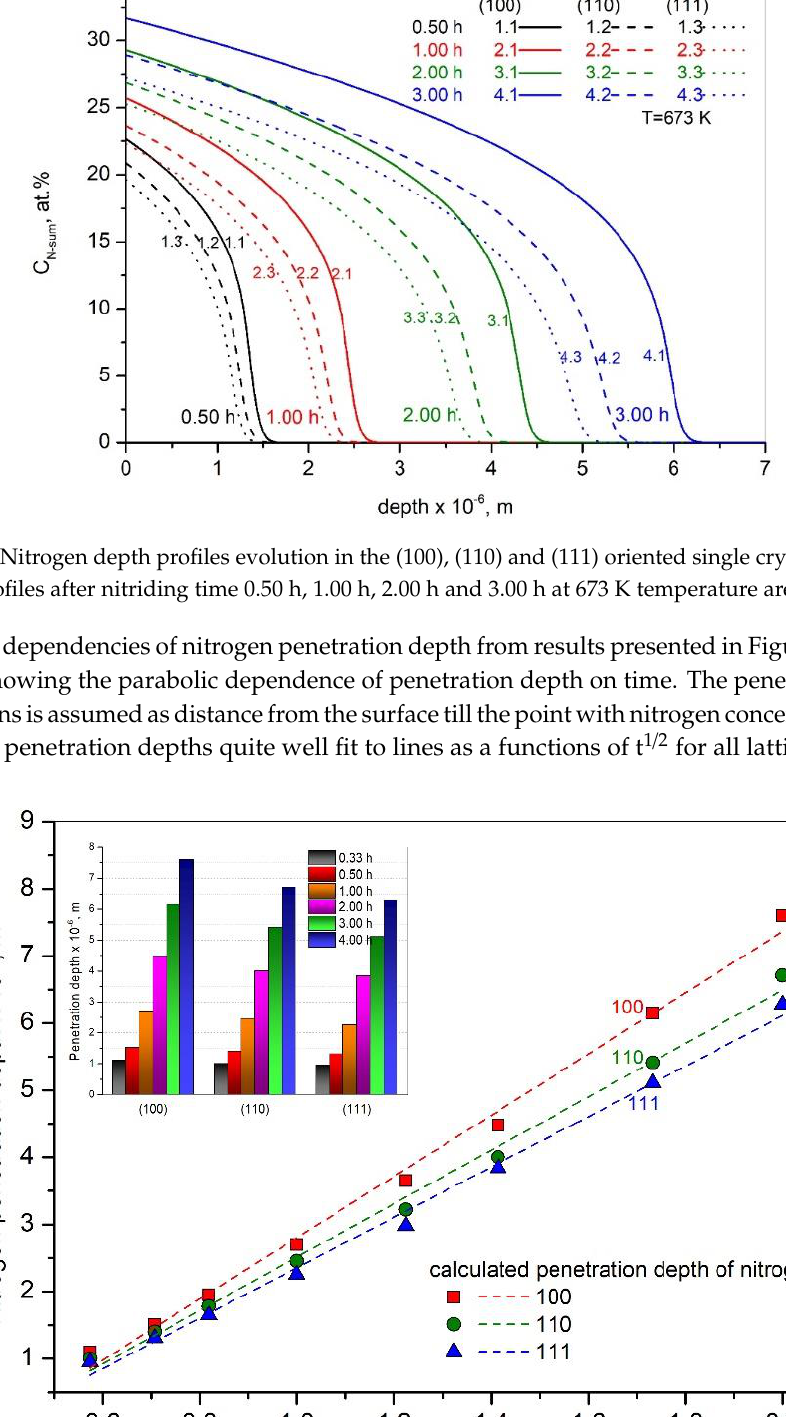
Figure 7. The dependence of penetration depth on diffusion coefficient for different crystalline orientations of AISI 316L single crystals (nitriding duration 1.00 h). During calculations, the diffusion coefficient was changed by changing temperature according to Arrhenius law. As mentioned before, the diffusion coefficient in our calculations in this work is independent on crystalline orientation. It can be seen from Figure 7 that different penetration of nitrogen for different lattice orientation occurs despite the same diffusion coefficient. With the crystalline orientation only parameters X stress and  N(hkl) are changed. Only these parameters are responsible for different penetration depth of nitrogen for different crystalline orientations despite the same diffusion coefficients. Functions of penetration depth on the square root of diffusion coefficient D 1/2 show linear dependence, confirming the validity of relation 𝑙~√𝐷𝑡 for TD + SID